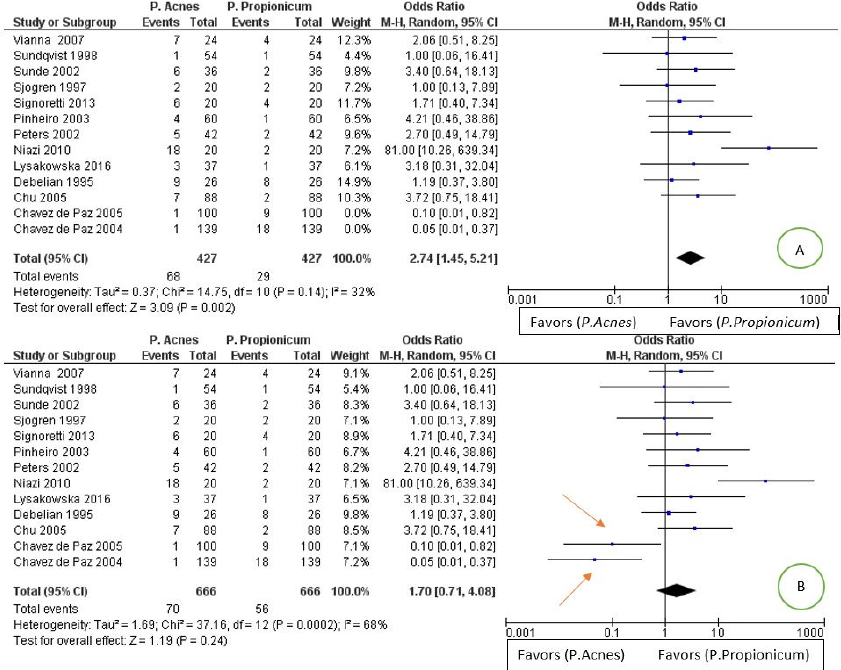
Figure 7. Image A: forest plot of the random effects model of the meta-analysis of the tertiary outcome; the arrows indicate the main sources of heterogeneity. Image B: forest plot with the exclusion of heterogeneity sources.